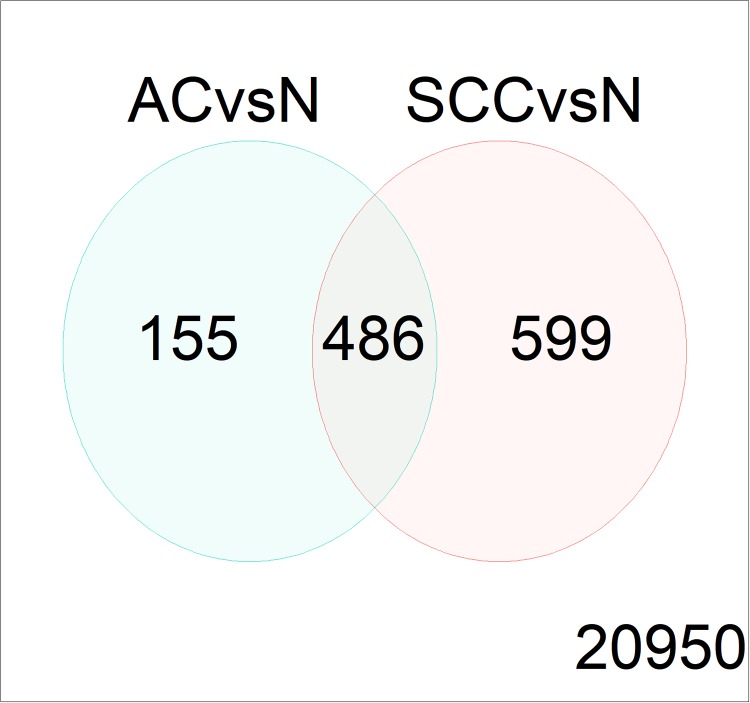
The number of DEGs in the comparison for the treat method.